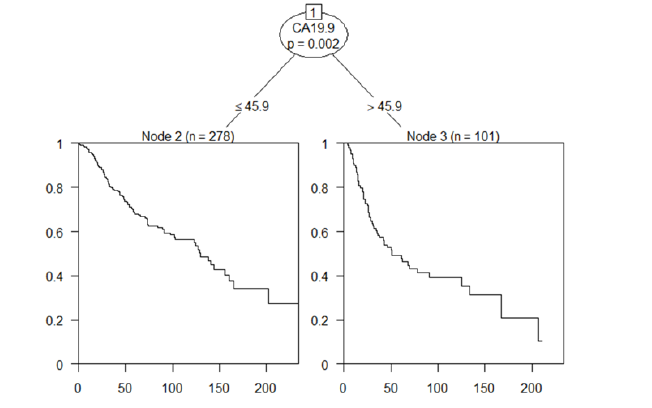
Figure 5. C-tree analysis: the optimal cutoff value of CA 19-9 was 46 U/mL. Table 2. Clinicopathologic characteristics according to the CA19-9